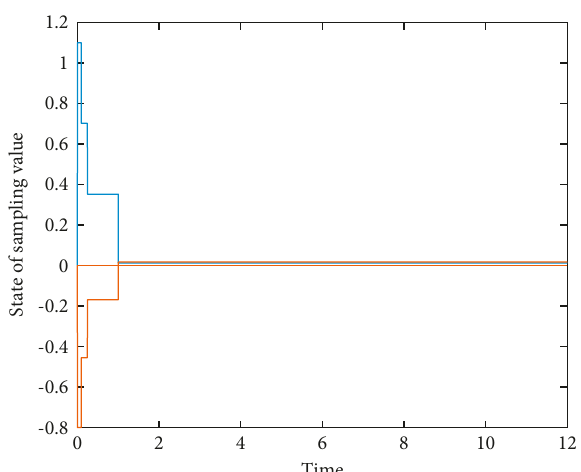
Figure 9: The state of sampling value is given when α